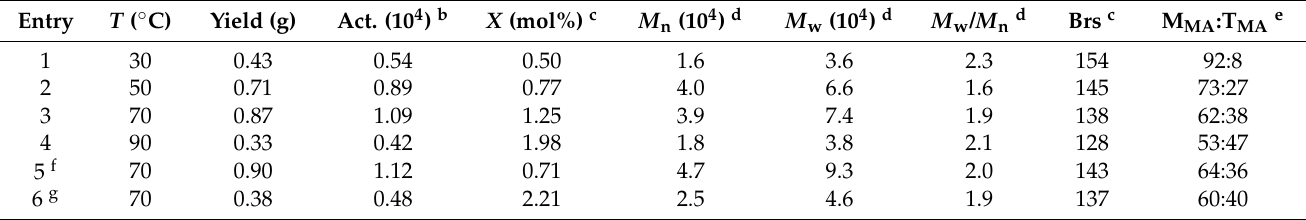
Table 5. Copolymerization of ethylene and MA catalysed by Ipty/ i Pr-Pd a .